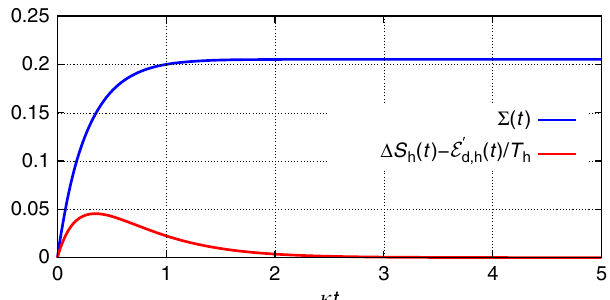
Fig. 6 Entropy change in a Carnot cycle. Change in entropy (in units of k B ) during stroke 2 of the modi fi ed Carnot cycle in Fig. 5 as a function of the stroke duration obtained by a numerical integration of the master equation. The upper (blue) curve corresponds to the reversibility criterion (7); it is seen that the inequality Σ ≥ 0 is far from being saturated. By contrast, our proposed inequality (11) is saturated (i.e., the equality sign applies) for suf fi ciently long stroke duration (red lower curve); here Δ S t Þ ¼ S ρ ð t Þð Þ (cid:4) S ρ ω ( t ) = (25 − h ð 0 ð Þ . Parameters: oscillator frequency 0.05 κ t ) κ , k B T h = 5 ħ κ and squeezing parameter r = 0.2, κ being the